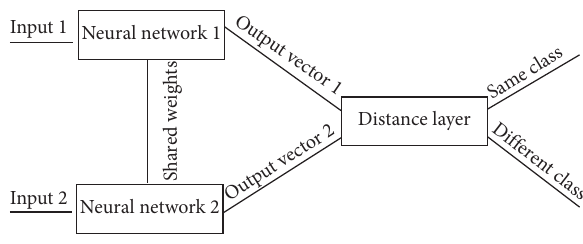
Figure 1: The Siamese neural network